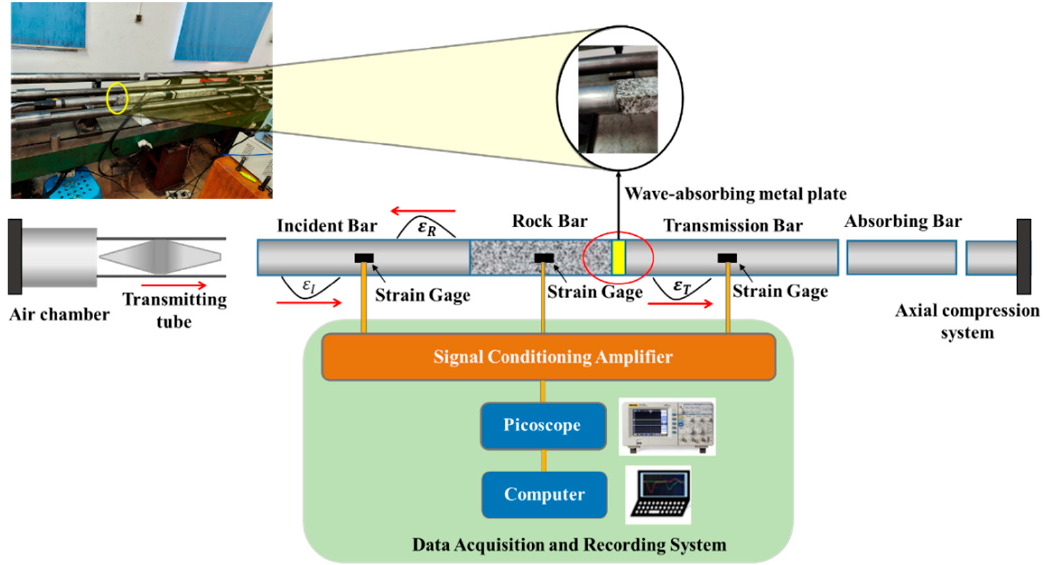
Figure 3. Schematic diagram of SHPB test system under static-dynamic-coupling loading.